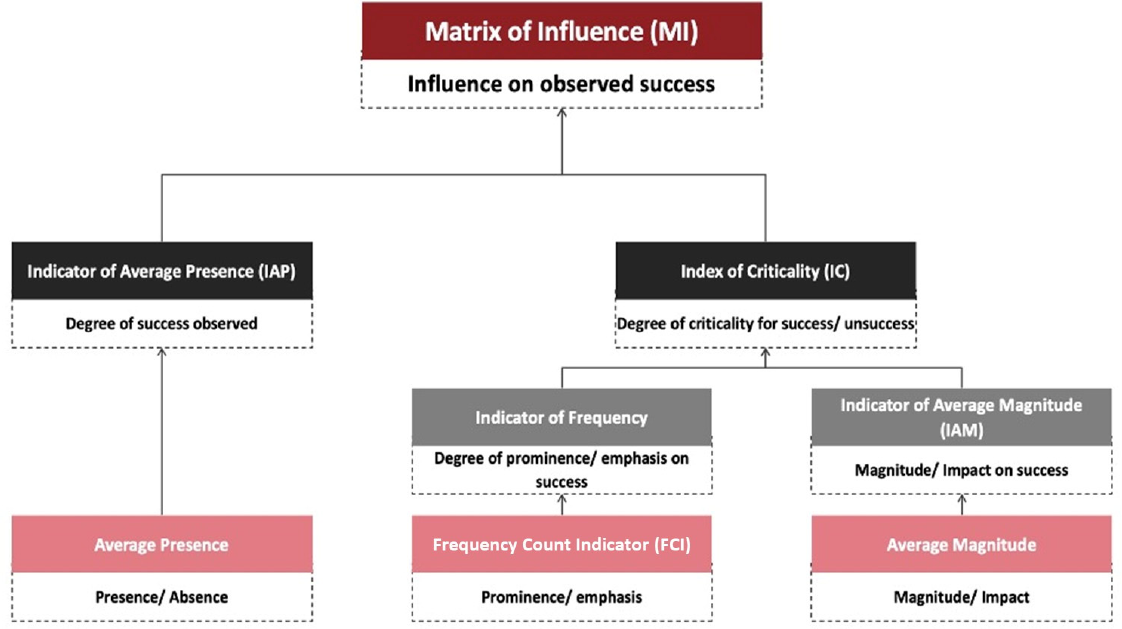
Figure 9. Diagram of the Architecture of Indexes and Indicators to Build the Matrix of Influence. Source: the authors.